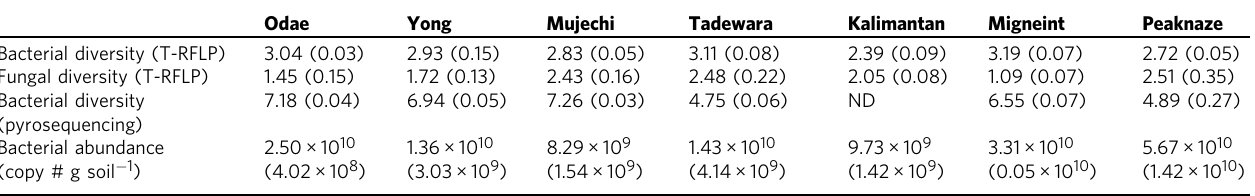
Table 1 Microbial diversity and abundances in seven peatland sites